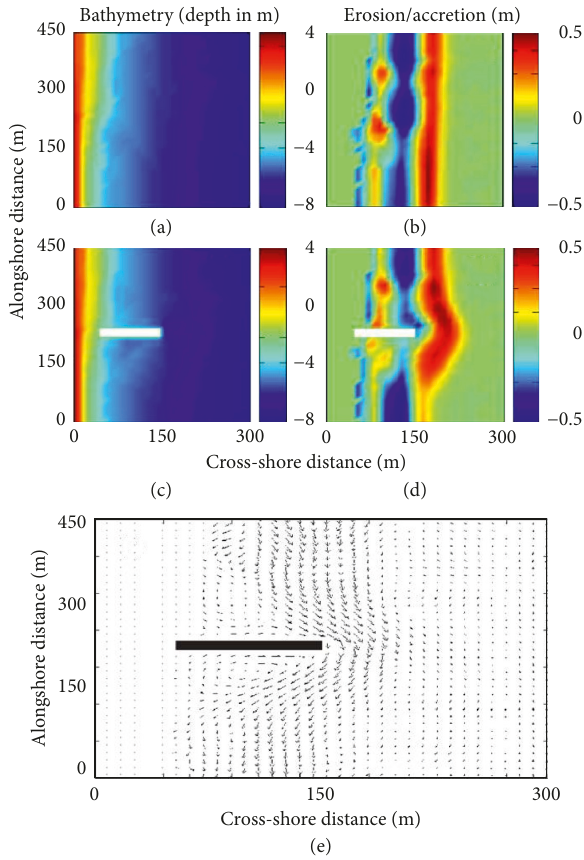
Figure 9: Examples of XBeach model output: (a) baseline ba- thymetry; (b) baseline erosion/accretion after 8 tidal cycles with oblique waves; (c) scheme starting bathymetry with a shore-normal groyne; (d) scheme erosion/accretion after 8 tidal cycles with oblique waves; and (e) snapshot of tidal and wave-induced flows around the